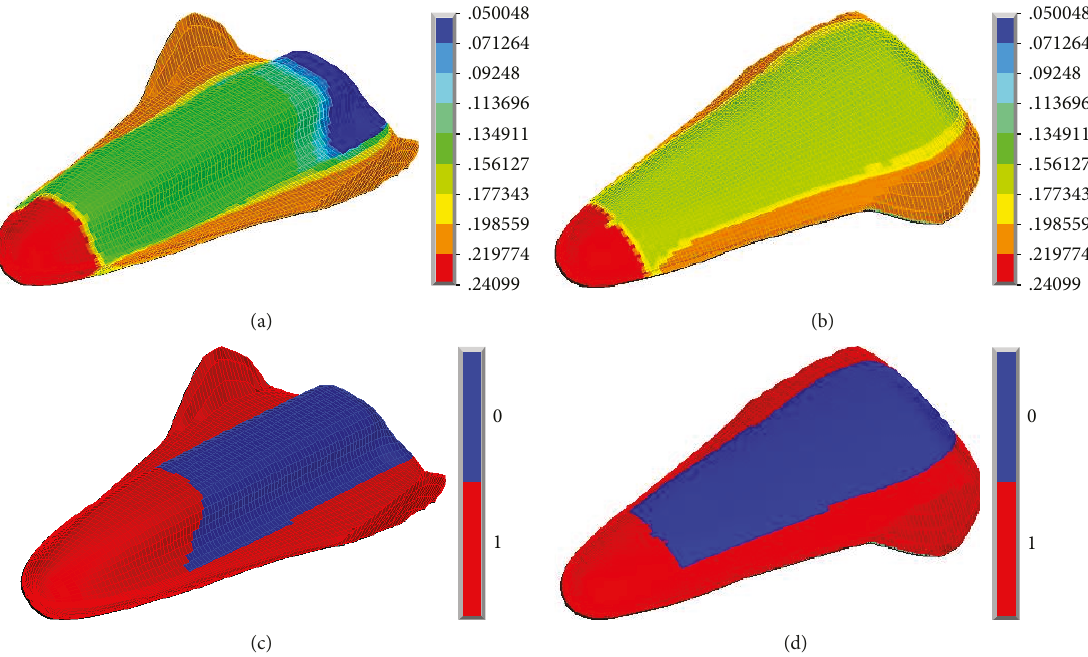
Figure 6: Example of thickness and material distribution over the RLV con fi guration (RLV-2): (a, b) thickness modulation (m); (c, d) two material maps (blue/red color indicates material “ 0 ” / “ 1, ” respectively).